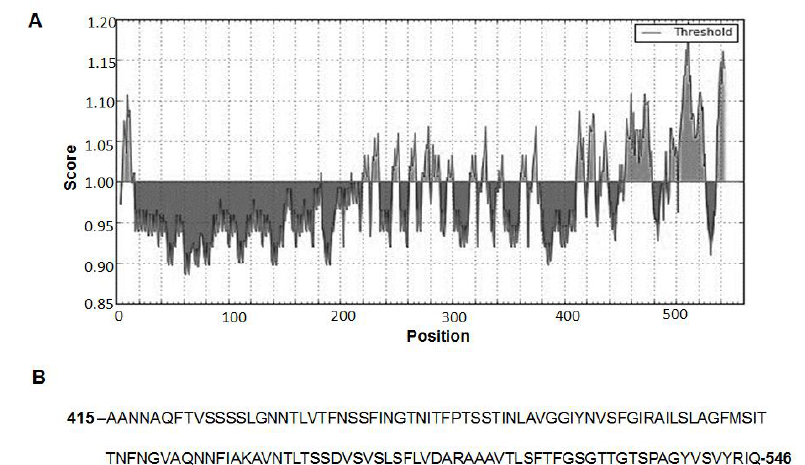
Figure 1. In silico analysis of BclA2 from Clostridioides difficile R20291. ( A ) Analysis of the B cell epitope propensity score (Kolaskar & Tongaonkar Antigenicity Method from Immune Epitope Database) of BclA2. The X- and Y-axes represent the sequence position and antigenic propensity score, respectively. The threshold value was generated by default by Immune Epitope Database (http://tools.iedb.org/bcell/). The regions above the threshold are antigenic. ( B ) Amino acid sequence of the 131 residues at the C-terminal end of BclA2 identified as a potential antigenic region and indicated as BclA2 CTD by Kolaskar & Tongaonkar Antigenicity Method.